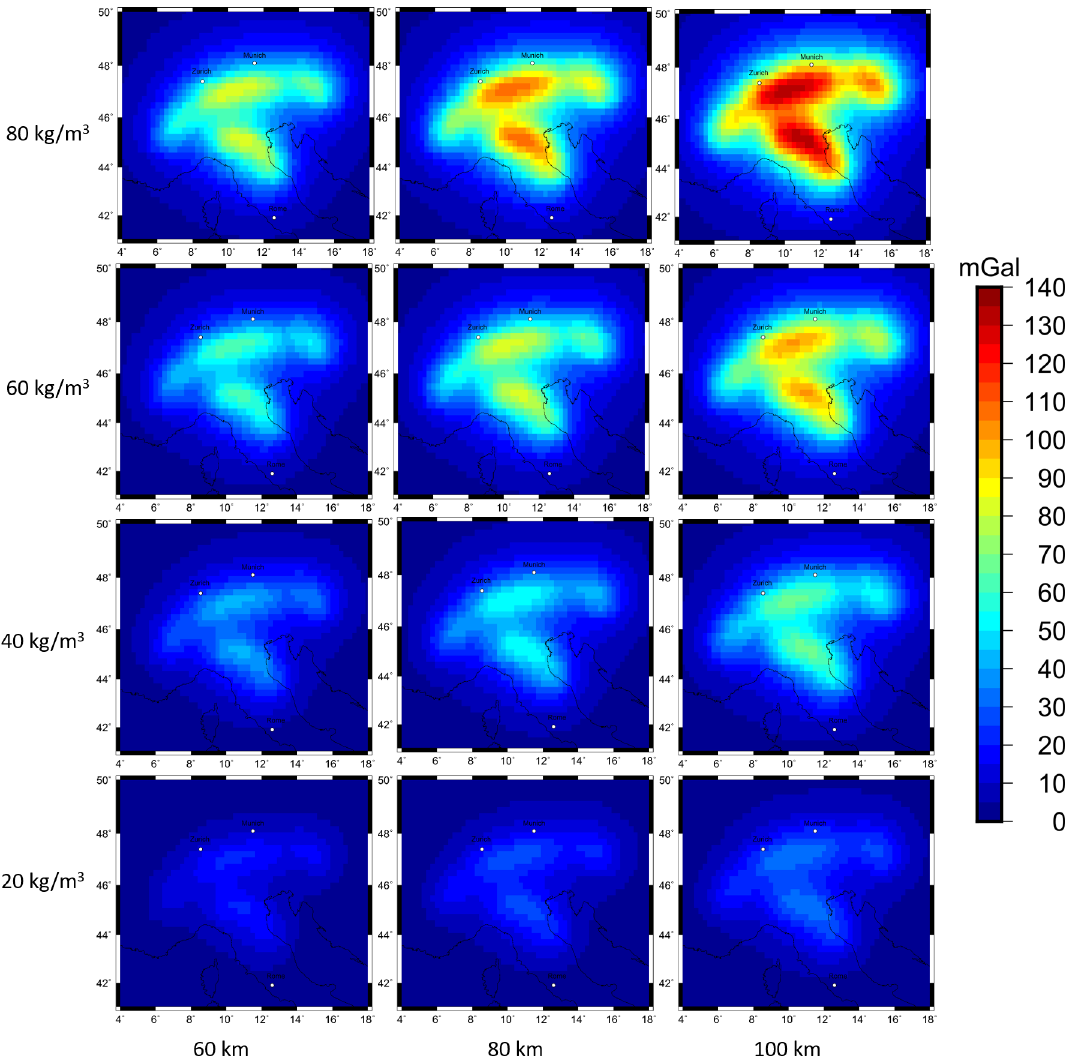
Figure 7. Forward-calculated gravity disturbance signal for 12 different combinations of density contrast and slab thickness for subcrustal slab Configuration 1 at a station height of 6040m.